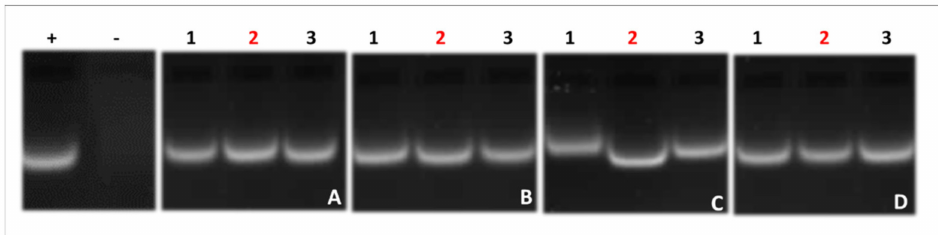
Figure 6. RNase A digestion assay of nanocomplexes. ( A ) G5D, ( B ) Au:G5D, ( C ) G5D: FA,